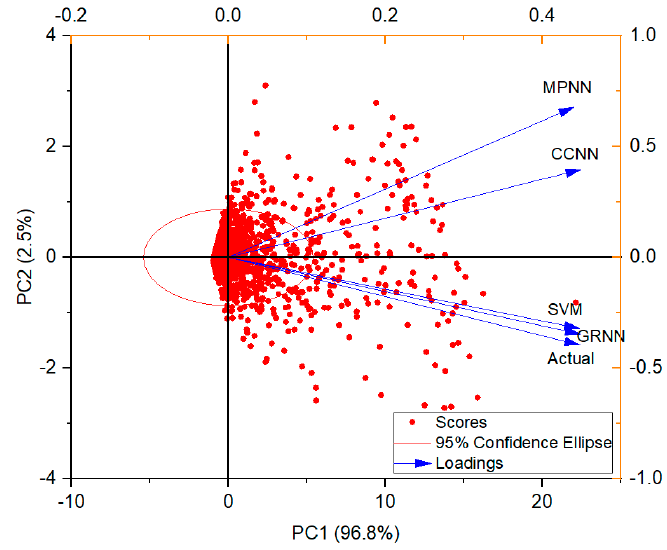
Figure 9. PCA for the actual wave-overtopping discharge and ANN and SVM models.